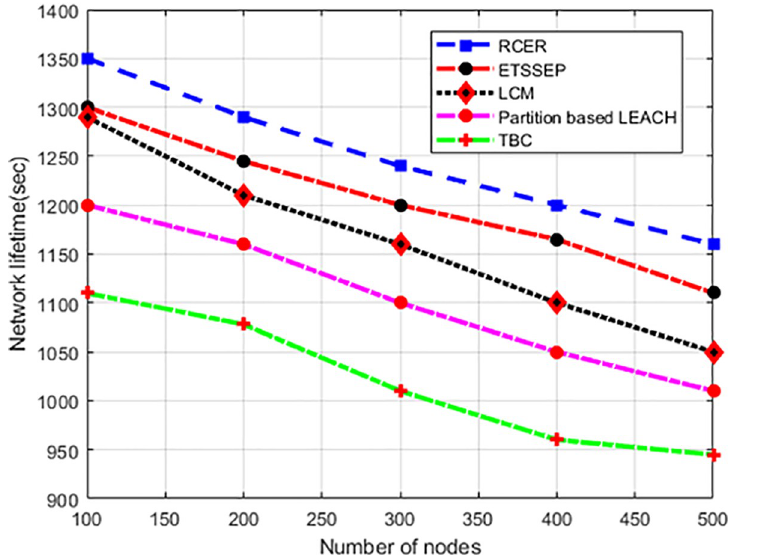
Fig 8. Network lifetime in high-density